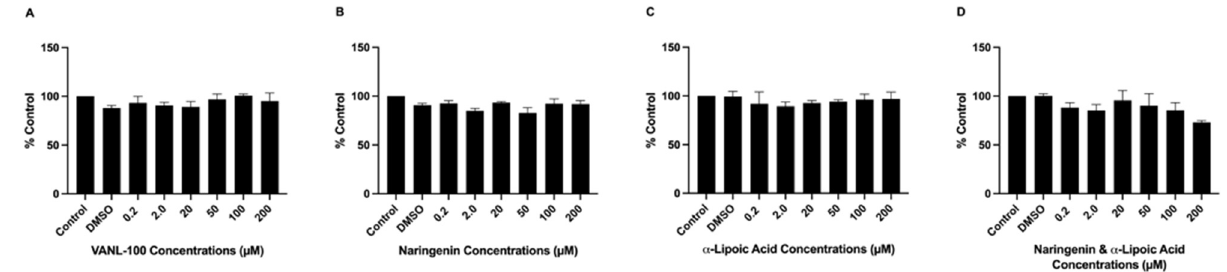
Figure 3. Effects of VANL-100, NAR, ALA, and NAR + ALA on cell viability. Cell viability, repre- sented as % control, is shown on the y-axis, and antioxidant concentrations are displayed on the x-axis. The bars represent the mean ± SEM of three independent experiments. Cells were incubated with different concentrations of each antioxidant and combination (0.2, 2.0, 20, 50, 100 and 200 μ M). ( A ) VANL-100; ( B ) NAR alone; ( C ) ALA alone; ( D ) NAR + ALA. None of the antioxidant compounds at any dose significantly induced cell loss or reduced cell viability. Statistical significance vs. controls was assessed using one-way ANOVA. p <